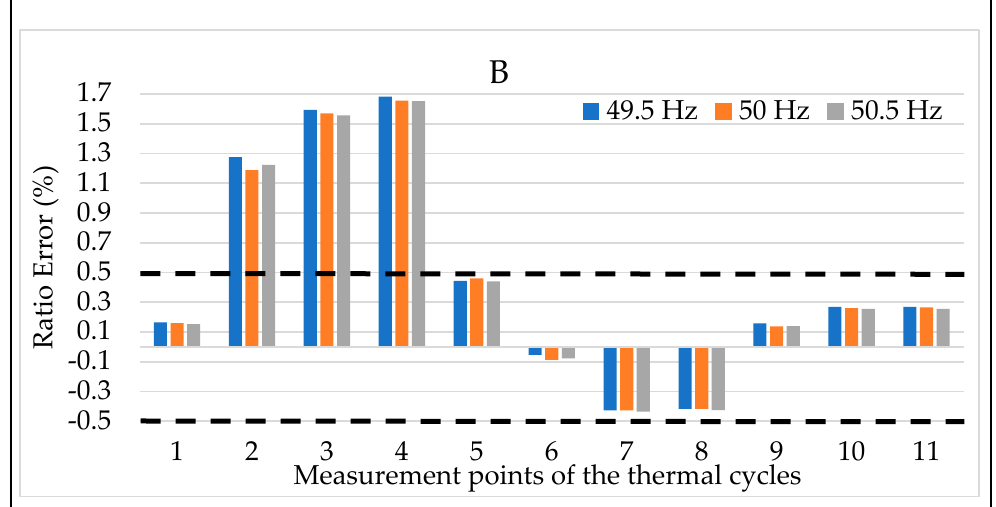
Figure 19. Ratio error vs. temperature + frequency for LPVT B.